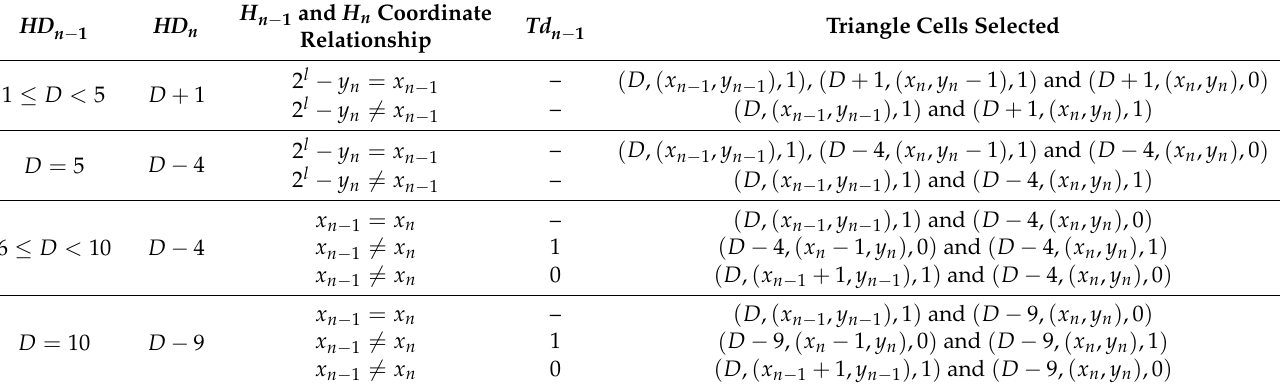
Table 6. Htotcode rule of the ( n − 1)th hexagon cell B 3 .